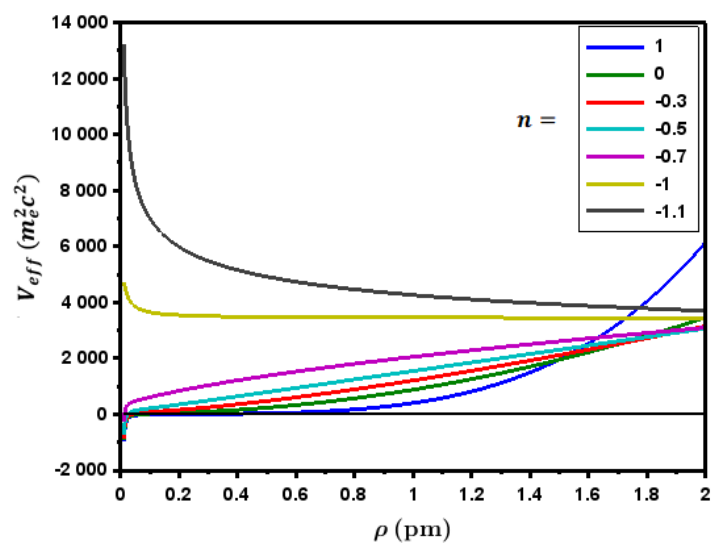
= 10 15 G pm − n . 0 = 0. Various potentials at ρ = 1 pm ef f